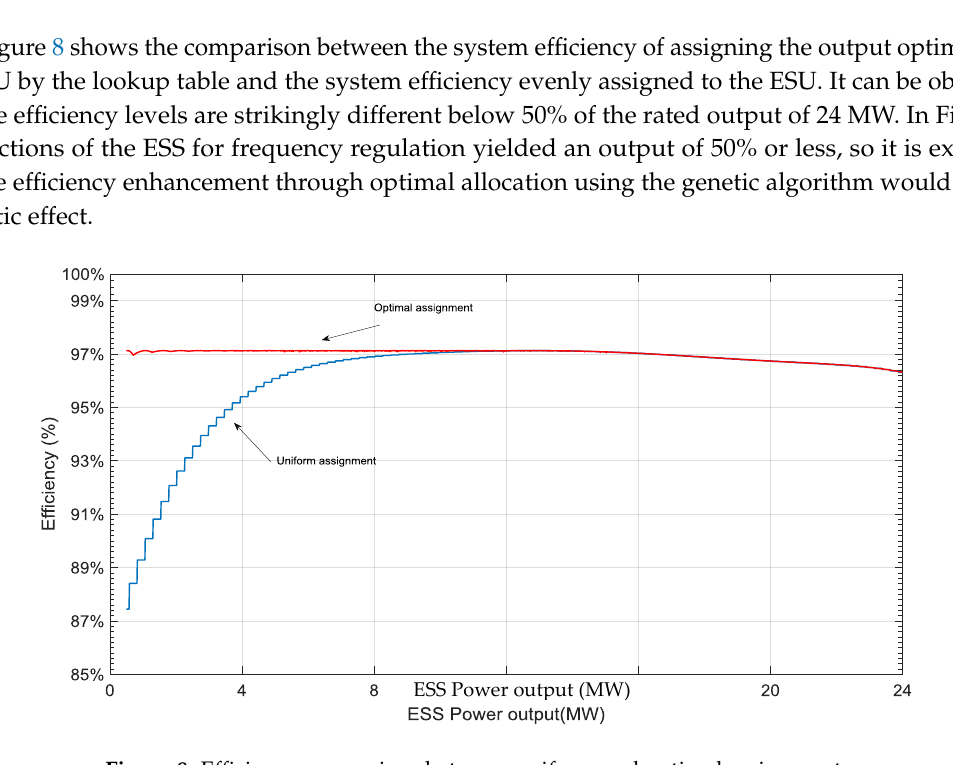
Figure 8. Efficiency comparison between uniform and optimal assignment.